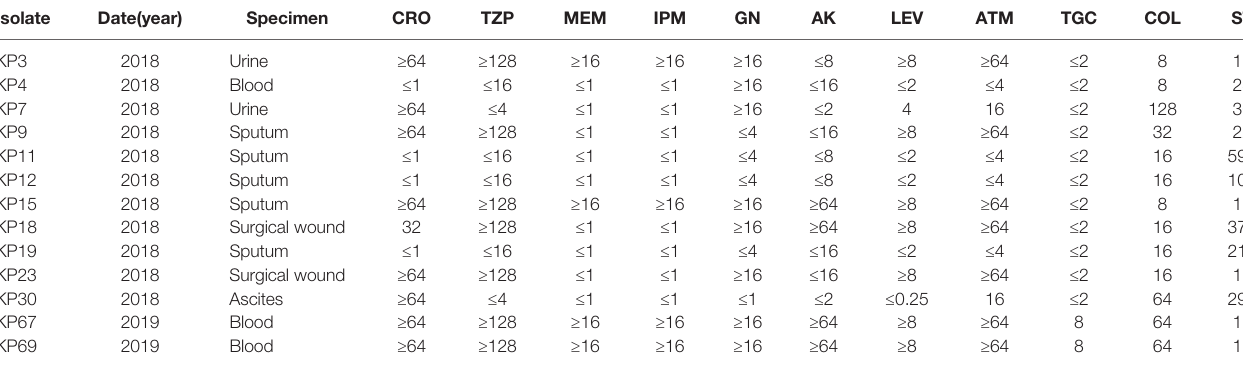
TABLE 1 | Clinical features, resistance pro fi les, and sequence types of colistin-resistant Klebsiella pneumoniae isolates.